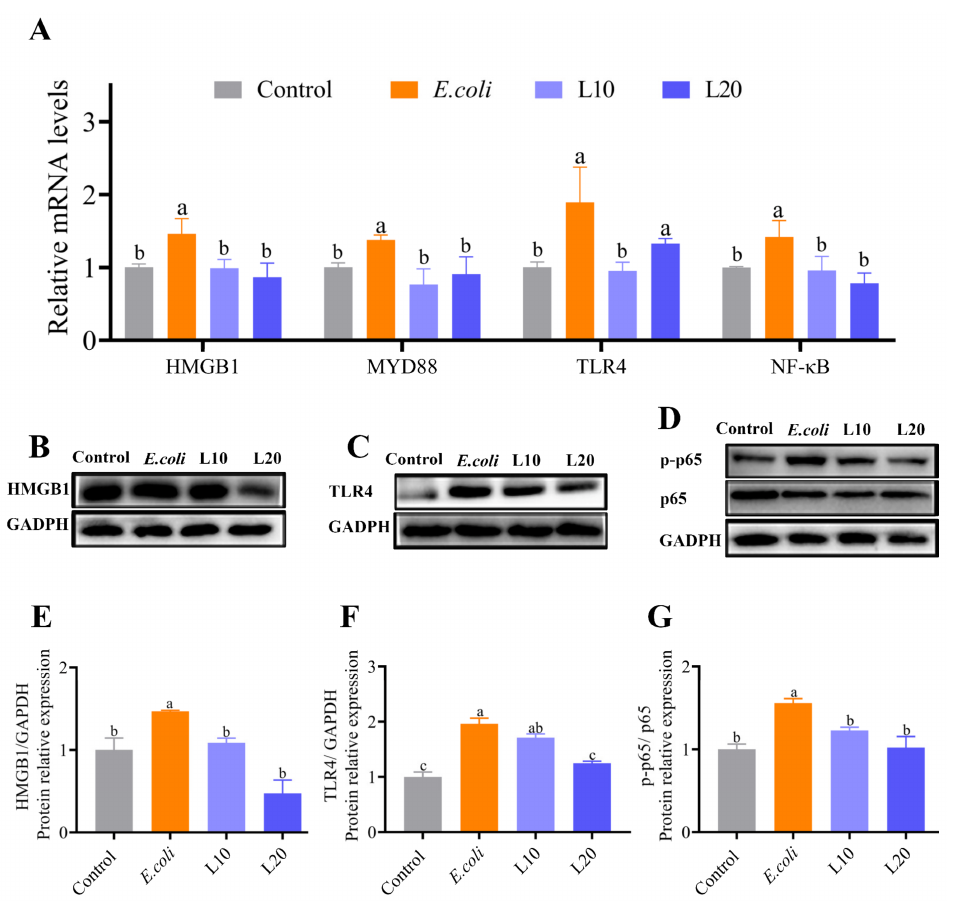
Figure 6. The effects of luteolin on HMGB1/TLR/NF- κ B pathway-related genes and protein levels. ( A ) Changes in the mRNA levels of HMGB1/TLR4/NF- κ B pathway-related genes in the control, E. coli , L10, and L20 groups, ( B – G ) The protein expression levels of HMGB1 (25 kDa), TLR4 (95 kDa), p-p65 (65 kDa), and p65 (65 kDa). The data are expressed as mean ± SD. A statistical difference ( p < 0.05) is shown by different